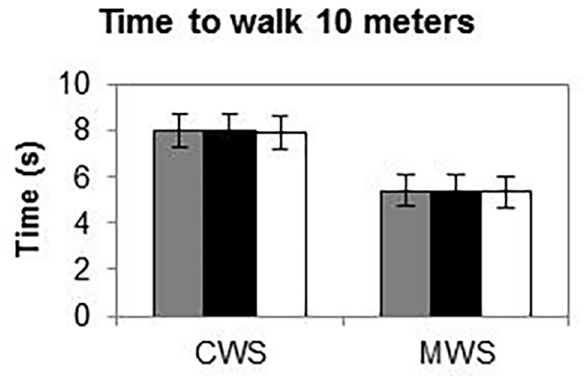
Fig 6. Time to walk 10 meters for CWS and MWS conditions. Bars represent average time to walk 10 meters for the multi-Kinect v2 set-up (gray bars), the Optotrak motion-registration system as the gold- standard reference (black bars) and the stopwatch as the clinical standard (white